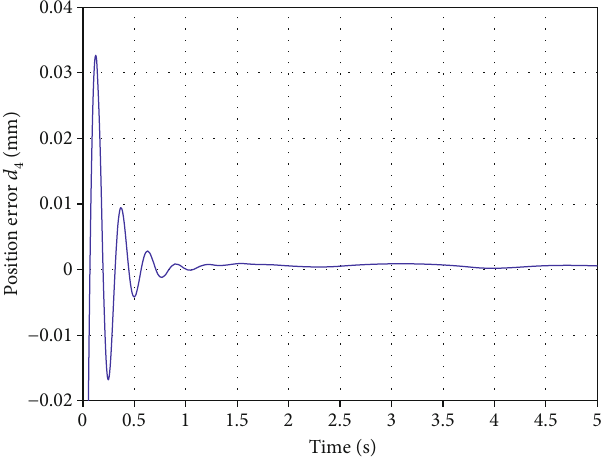
Figure 12: The driving force error of the third actuated . 4